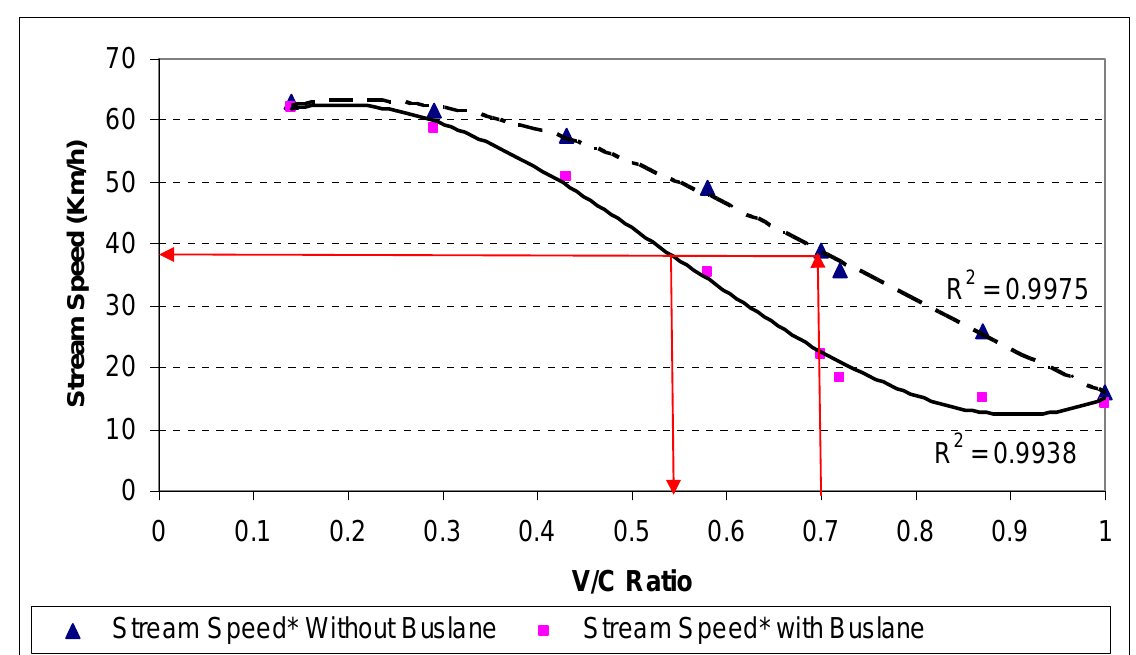
Figure 12. Traffic stream speed on the roadway with and without bus lane * Stream of all motorised vehicles except